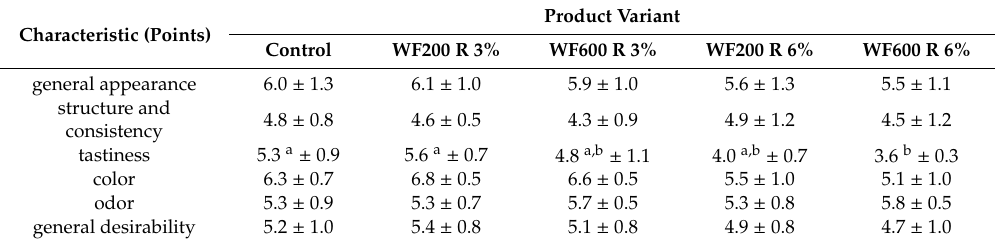
Table 4. Sensory quality of the model homogenized sterilized canned meat products (mean ± standard